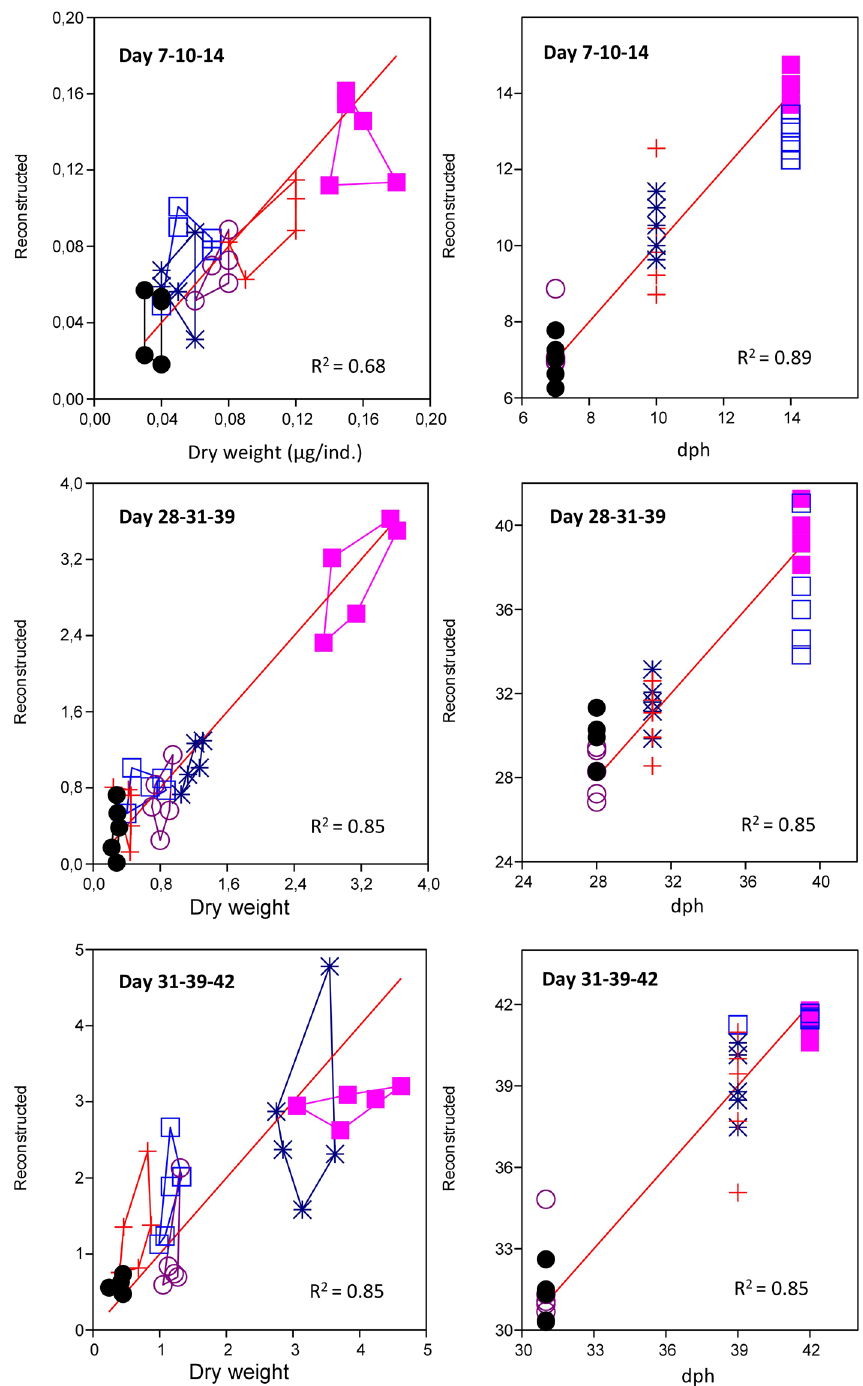
Figure 4. Reconstruction of individual weight (left) and age (right) data of cod larvae based on microbial community composition using factor analysis and environmental regression (CABFAC). dph refers to days post hatching. In each panel the youngest stage is shown by circles, the medium by cross and star, and the oldest by squares. Results for the last two gels are presented in Figure